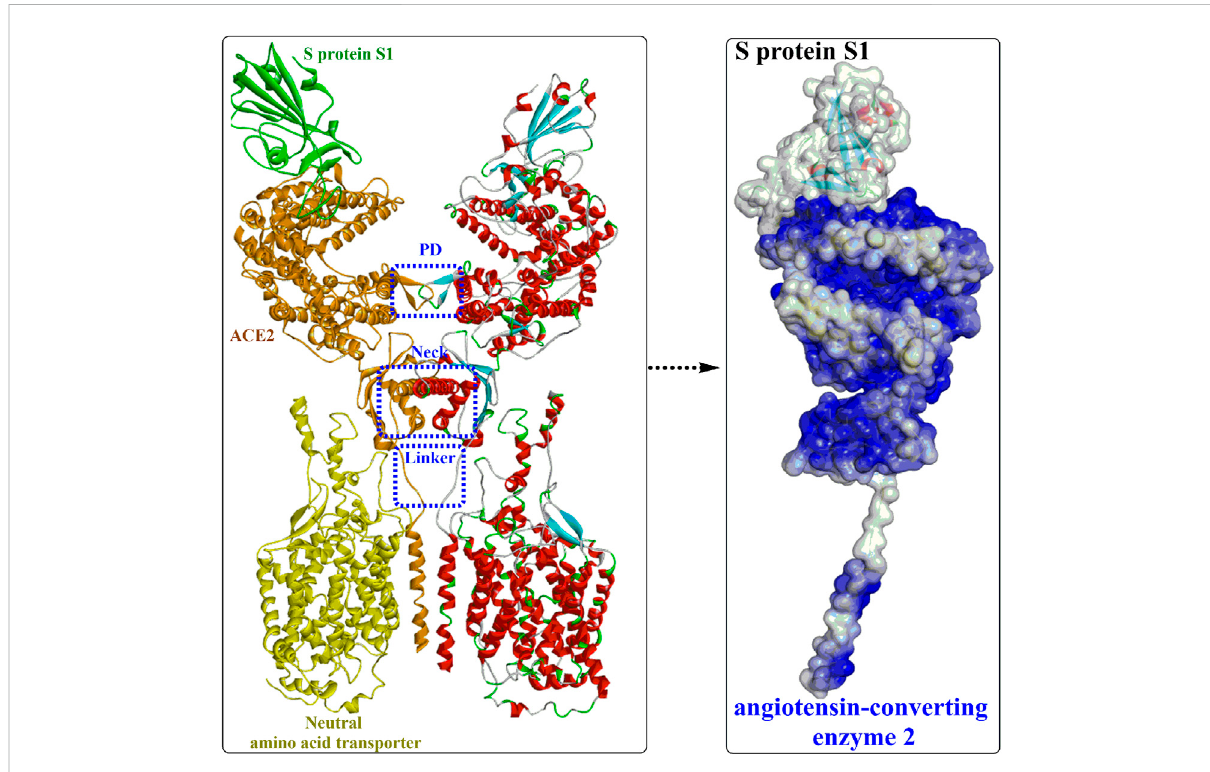
FIGURE 3 Overall structure of the RBD-ACE2-neutral amino acid transporter complex (PDB ID: